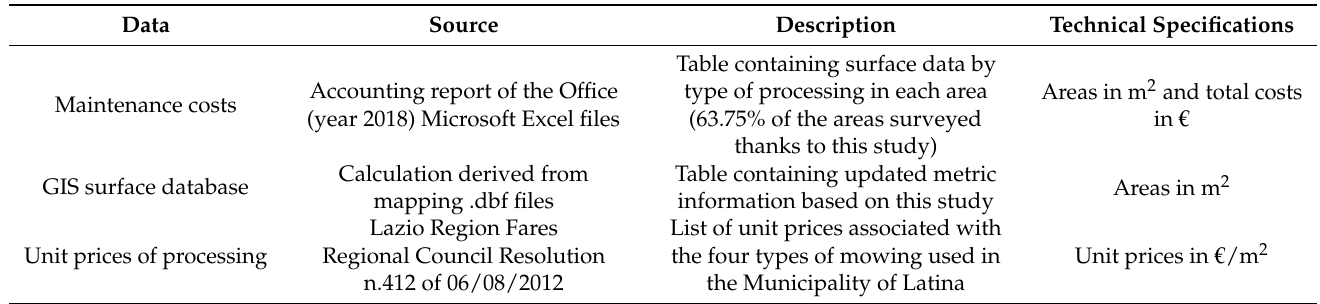
Table 4. Source data for the estimation of the maintenance costs. GreenCAL tool determines mainte- nance costs in relation to the extension of the green